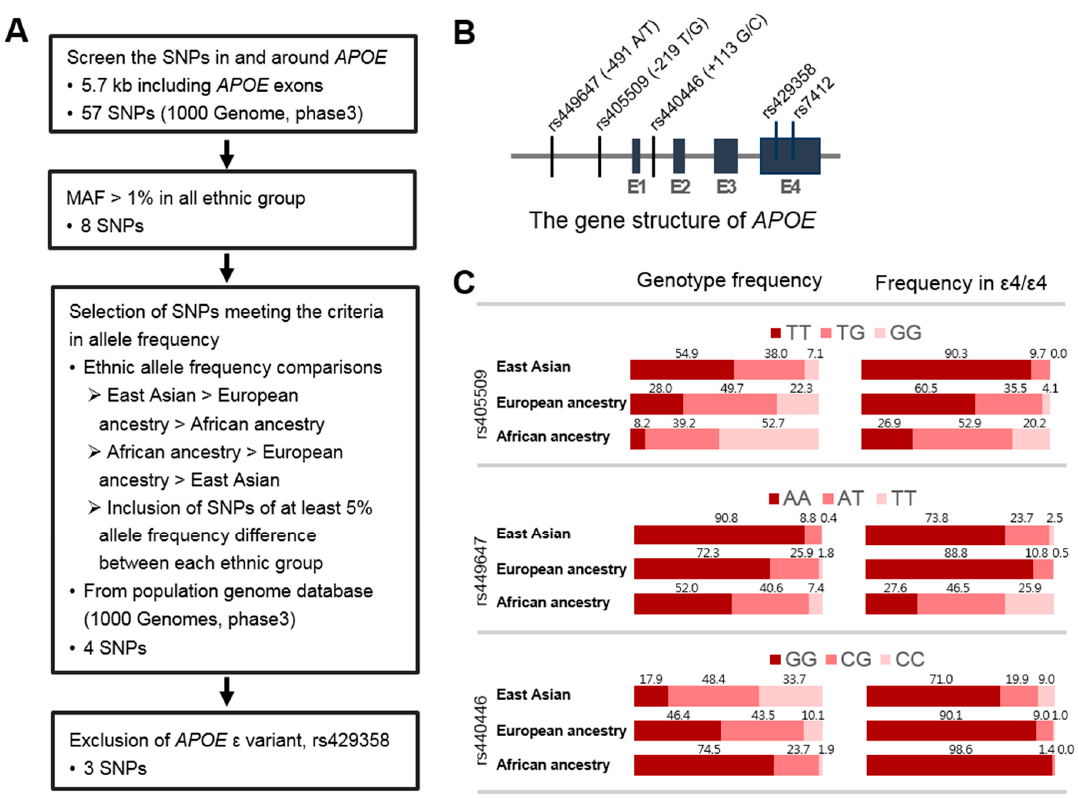
Figure 1. Single nucleotide polymorphisms (SNPs) in the APOE region modulate Alzheimer’s disease risk associated with the apolipoprotein E ( APOE ) ε 4 / ε 4 genotype. ( A ) Flow diagram showing the strategy for screening SNPs. ( B ) APOE gene structure. ( C ) Genotype frequencies for rs449647 ( − 491 A/T), rs405509 ( − 219 T/G), rs440446 (+113 G/C), rs429358, and rs7412 among all individuals and ε 4/ ε 4